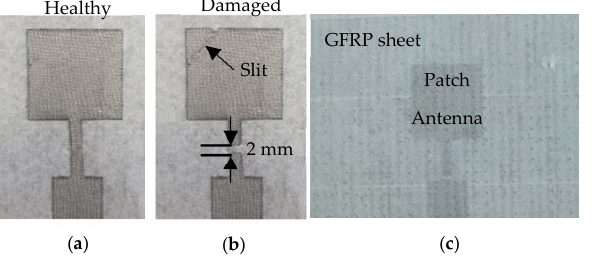
Figure 10. Photographs of ( a ) healthy and ( b ) damaged patch antenna fabricated using metal mesh, and ( c ) damaged antenna covered with a GFRP sheet.